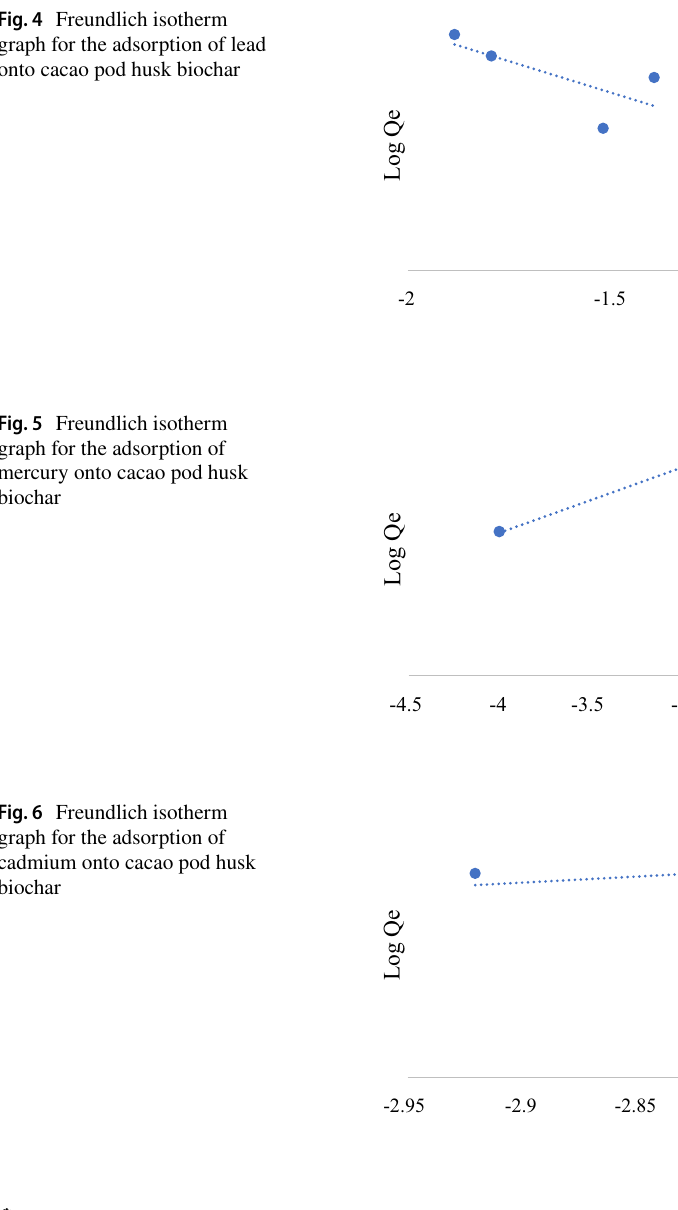
y = -1.7652x - 0.1673 R² = 0.5133